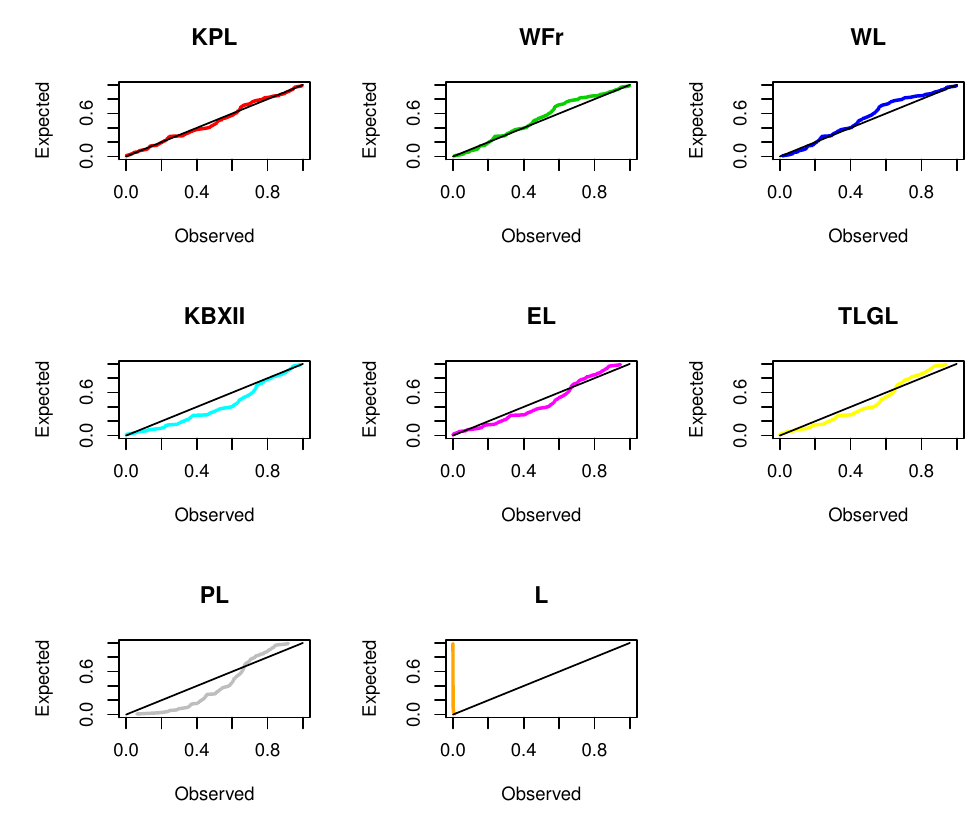
Figure 5. Fitted PP plots of the distributions for data set